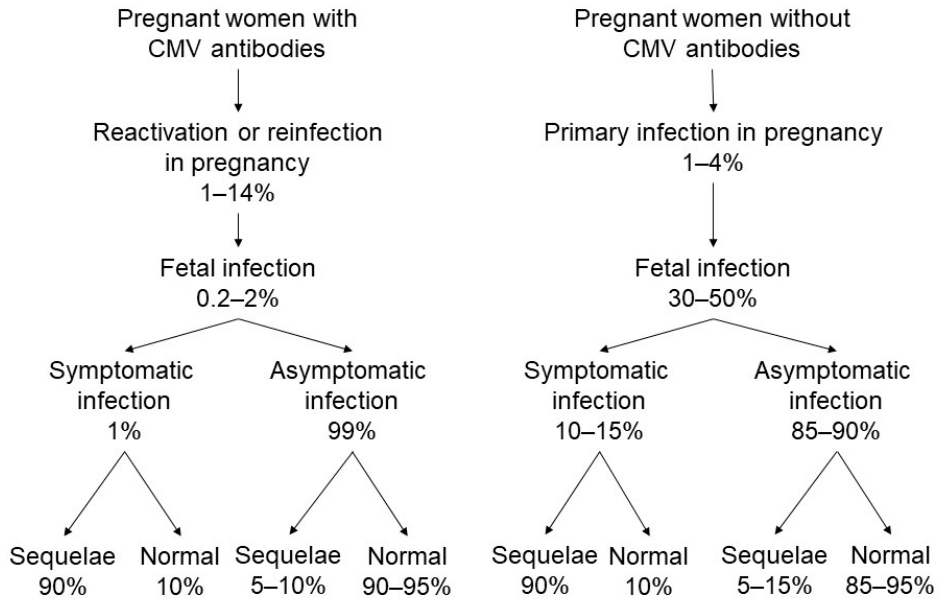
Figure 1. Cytomegalovirus (CMV) transmission from mother to fetus and potential disabilities in infants with congenital CMV infection.